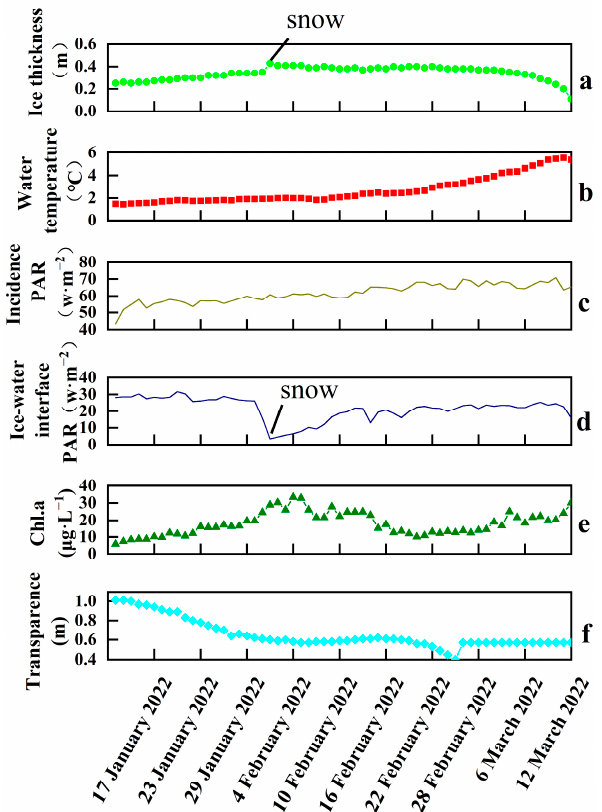
Figure 2. Changes of various environmental factors during the ice-covered period. (( a ), Ice thickness; ( b ), water temperature; ( c ), ice incident PAR; ( d ), ice-water interface PAR ; ( e ), Chl.a; ( f ), transparency).